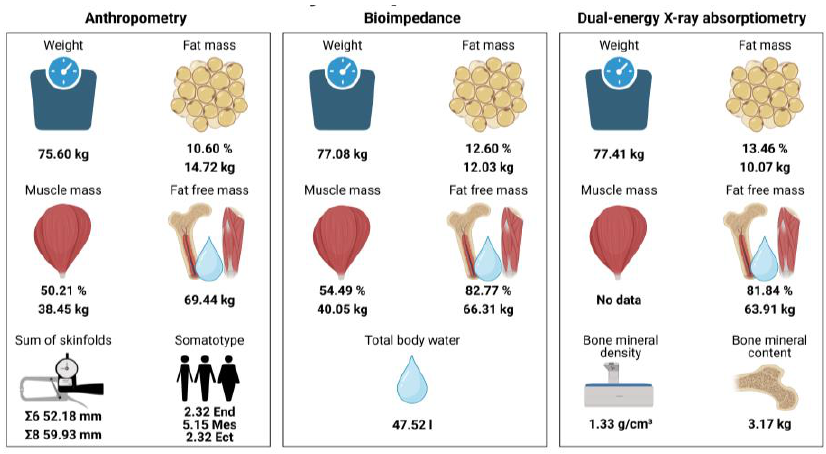
Figure 6. Guidance values for body composition differentiated by measurement method.